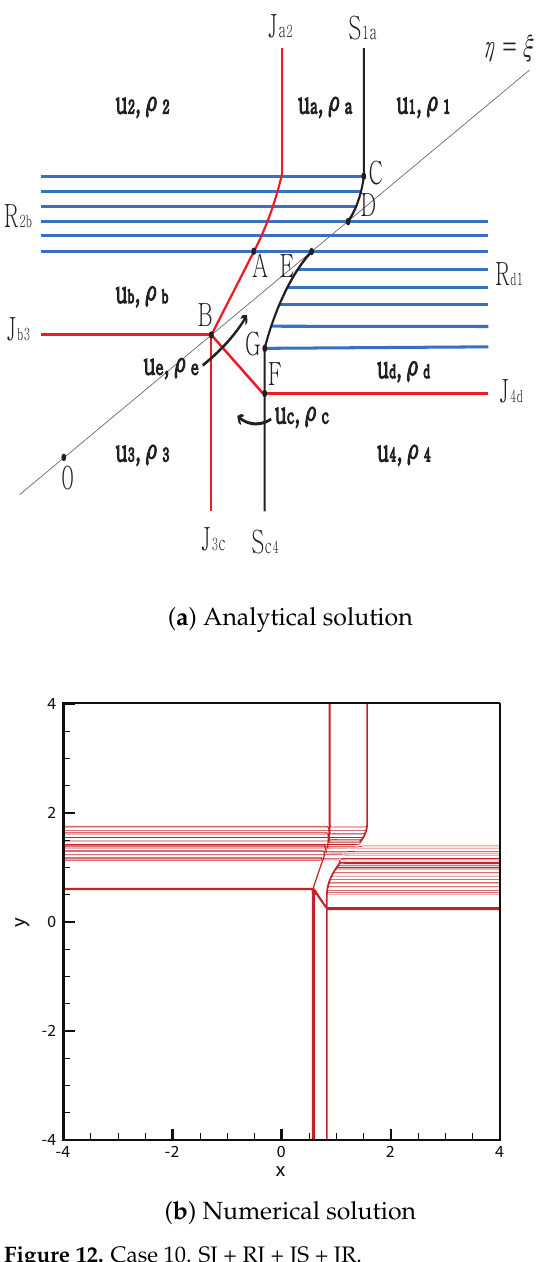
Figure 12. Case 10. SJ + RJ + JS +